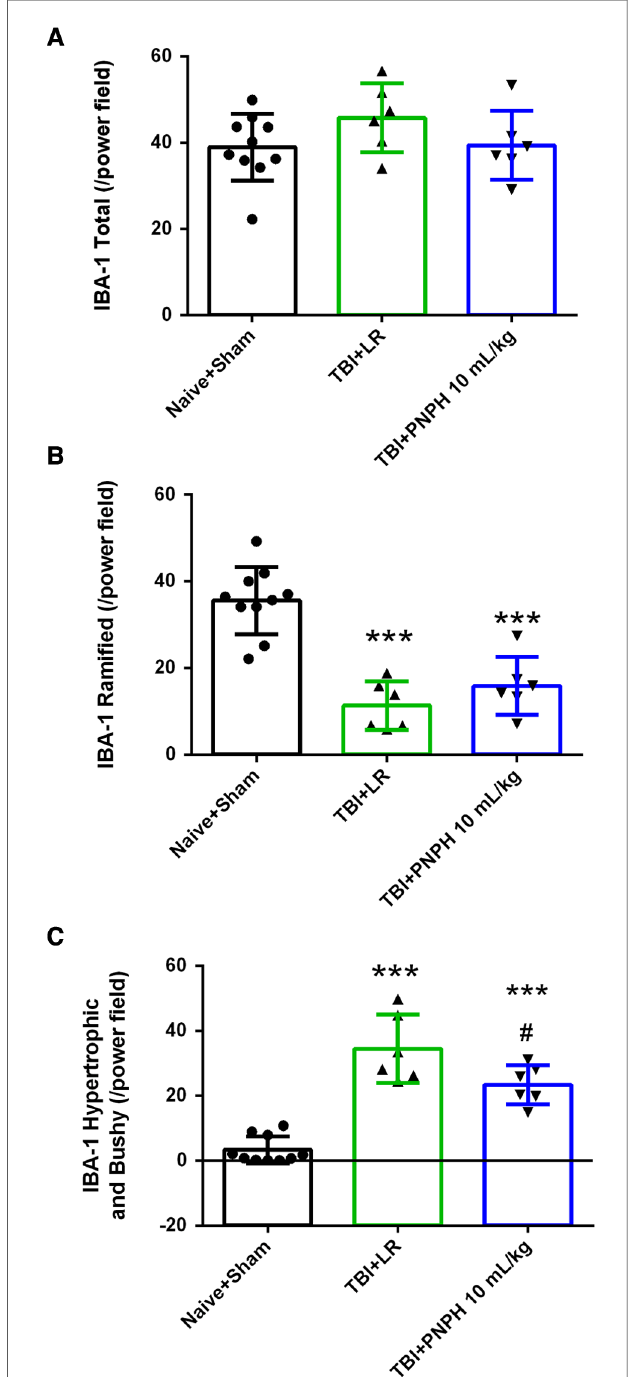
FIGURE 11 Effect of PNPH on microglial activation after TBI without HS. The number of Iba-1 – positive cells ( A ), rami fi ed Iba-1 – positive cells ( B ), and hypertrophic plus bushy Iba-1 – positive cells ( C ) are plotted for the combined Naïve+Sham group ( n =10) and for TBI groups infused with 10 ml/kg lactated Ringer ’ s (LR) solution ( n =6) and 10 ml/kg PNPH ( n = 6). The number of Iba-1 – positive cells did not change signi fi cantly 4 days after TBI, whereas the number of Iba-1 cells classi fi ed as rami fi ed decreased signi fi cantly in both TBI groups. Hypertrophic and bushy Iba- 1 cell number markedly increased in the TBI group with LR infusion and the increase was attenuated with PNPH infusion. Mean±SD and individual data for each pig are shown. *** P <0.001 vs. combined Naïve +Sham group, # P <0.05 vs. TBI group with LR treatment determined by one-way ANOVA and the Holm-Sidak procedure for multiple